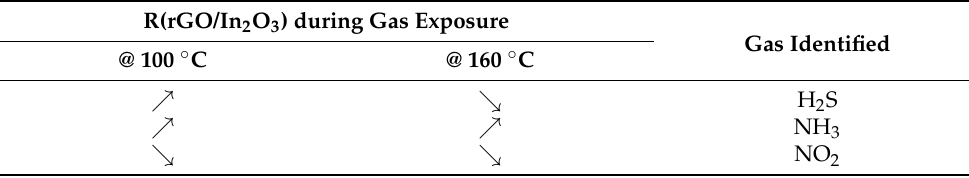
Table 2. Variation function of microsensor resistance during exposure step to gases for 2 different working temperatures. The gas can be identified from the sign of resistance